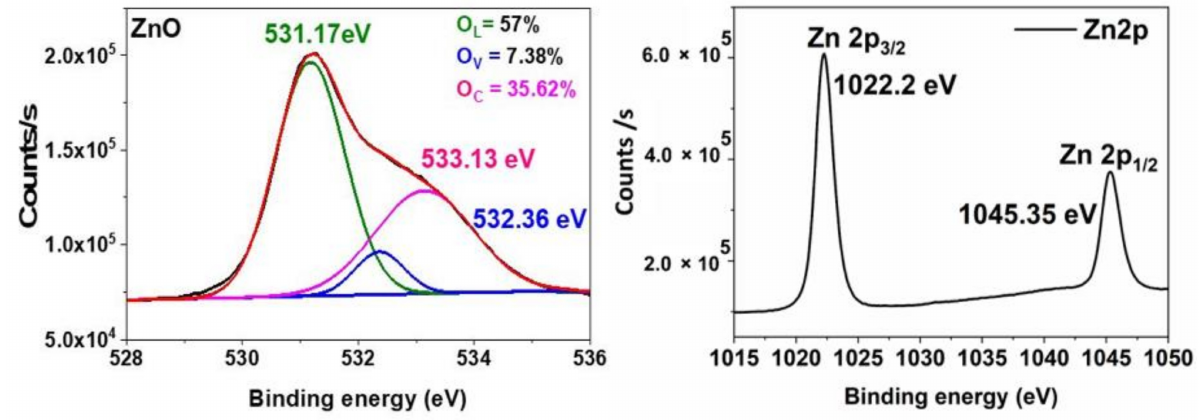
Figure 3. O1s and Zn2p core-shell XPS spectra of